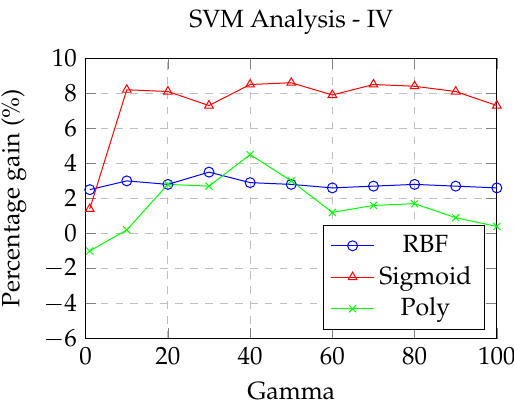
Figure 11. PCA comparison on SVM with n _ features =